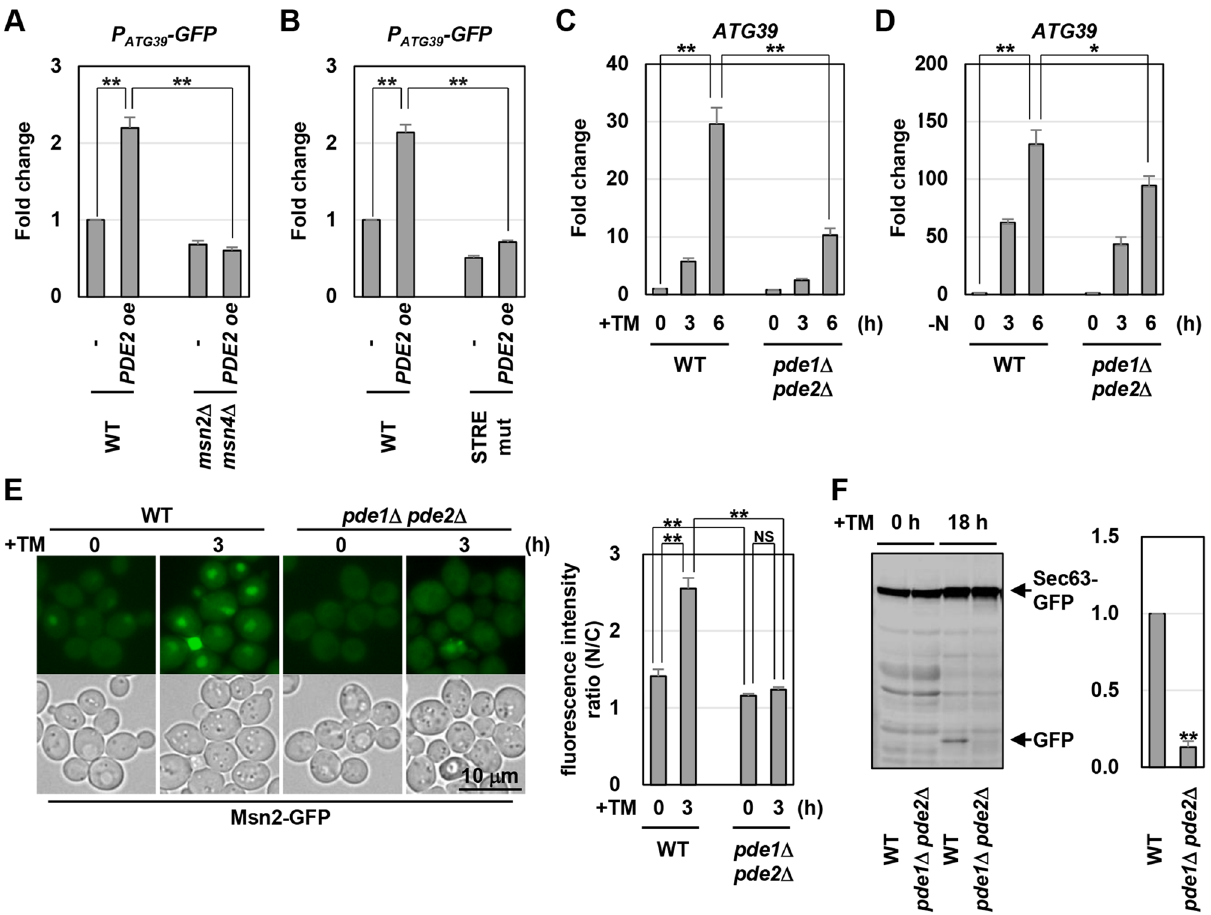
Figure 5. Pde1/2 positively regulate ATG39 expression via Msn2/4. ( A ) Effects of PDE2 overexpression on expression of the P ATG39 -GFP reporter in the msn2 msn4 mutant cells. Wild-type (WT) and msn2 msn4 mutant strains harboring the P ATG39 -GFP reporter and the plasmids with or without the PDE2 genes were grown at 25 °C until exponential phase and then harvested. The GFP mRNA levels were quantified by qRT-PCR analysis, and relative mRNA levels were calculated using ACT1 mRNA. The values are plotted as the fold change from wild-type cells harboring the empty plasmids. The data show mean ± SEM (n = 4). ** P < 0.01 as determined by Student’s t -test. ( B ) Effects of PDE2 overexpression on expression of mutated P ATG39 -GFP reporter. Wild- type (WT) cells harboring wild-type or mutated P ATG39 -GFP reporters and the plasmids with or without the PDE2 genes were grown at 25 °C until exponential phase and then harvested. The GFP mRNA levels were quantified by qRT-PCR analysis, and relative mRNA levels were calculated using ACT1 mRNA. The values are plotted as the fold change from cells harboring wild-type P ATG39 -GFP reporter and the empty plasmids. The data show mean ± SEM (n = 4). ** P < 0.01 as determined by Student’s t -test. ( C , D ) The ATG39 mRNA levels in pde1 pde2 mutant. Wild-type (WT) and pde1 pde2 mutant strains were grown at 25 °C until exponential phase and treated with 3 μg/ml tunicamycin (TM) ( C ) or incubated under nitrogen-starved conditions ( D ) for the indicated time. The ATG39 mRNA levels were quantified by qRT-PCR analysis, and relative mRNA levels were calculated using ACT1 mRNA. The values are plotted as the fold change from wild-type cells at the time of TM addition or nitrogen removal. The data show mean ± SEM (n > 3). * P < 0.05 and ** P < 0.01 as determined by Student’s t -test. ( E ) Cellular localization of Msn2. Wild-type (WT) and pde1 pde2 mutant strains harboring GFP-tagged MSN2 were grown at 25 °C until exponential phase and treated with 3 μg/ml tunicamycin (TM) for 3 h, and subjected to microscopy. The fluorescence intensities were measured, and then the ratios (N/C) of the fluorescence intensity per unit area in the nucleus/that in the cytoplasm were calculated. The graphs show mean ± SEM (n = 30). ** P < 0.01 as determined by Student’s t -test. NS, not statistically significant ( P > 0.05). Scale bar, 10 μm. ( F ) Sec63-GFP degradation in ER-stressed pde1 pde2 mutant. Wild-type (WT) and pde1 pde2 mutant strains harboring GFP-tagged SEC63 were grown at 25 °C until exponential phase and treated with 3 μg/ ml tunicamycin (TM) for 18 h. Extracts prepared from each cell were immunoblotted with anti-GFP antibodies. The intensities of free GFP were measured and normalized to the Sec63-GFP level. The values are plotted as the fold change from wild-type cells. The data show mean ± SEM (n = 3). * P < 0.01 as determined by Student’s t